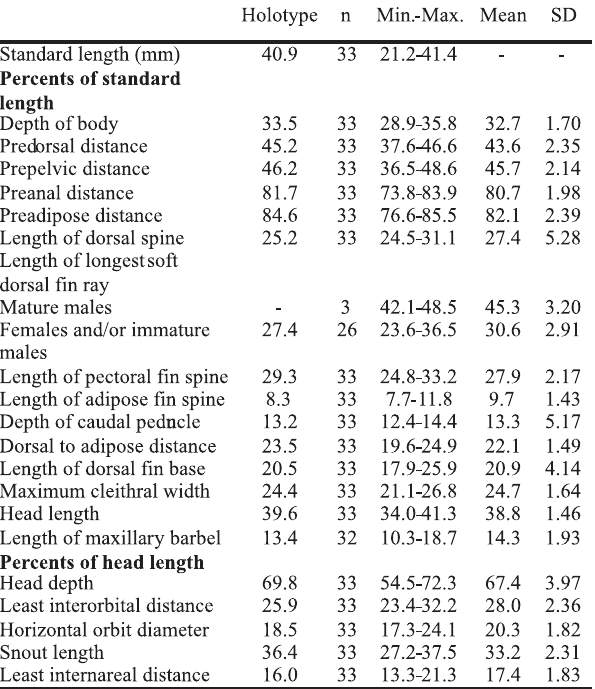
Table 1. Morphometric data of the holotype and paratypes of Corydoras tukano (ANSP 179201, n = 1; CAS 217960, n = 1; INPA 21423, n = 2; MNRJ 25355, n = 1; MZUSP 64096, n = 4; MZUSP 65689, n = 3; MZUSP 81179, n = 2; MZUSP 81194, n = 5; MZUSP 81244, n = 9; MZUSP 81276, n = 2; MZUSP 81153, n = 3). SD = Standard deviation.